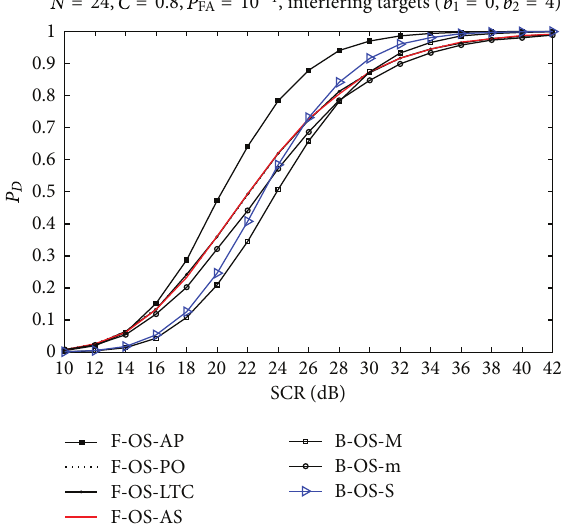
F 6: PD versus SCR based on ML CFAR algorithm in local sensors when SCR